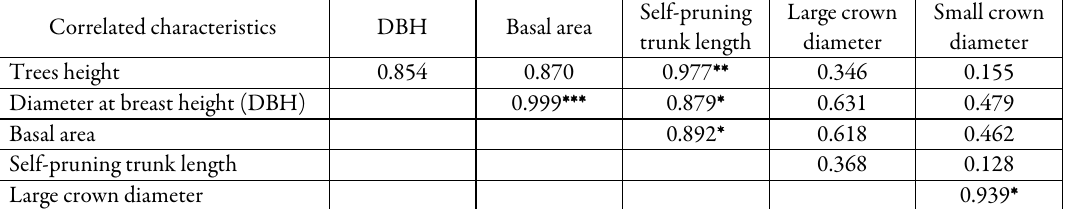
Figure 3. Coefficient of variability (CV%) for the main growth elements of R. pseudoacacia plus trees selected from the five stands Table 2. Phenotypic correlations between the analysed characteristics of R. pseudoacacia plus trees selected from the five stands